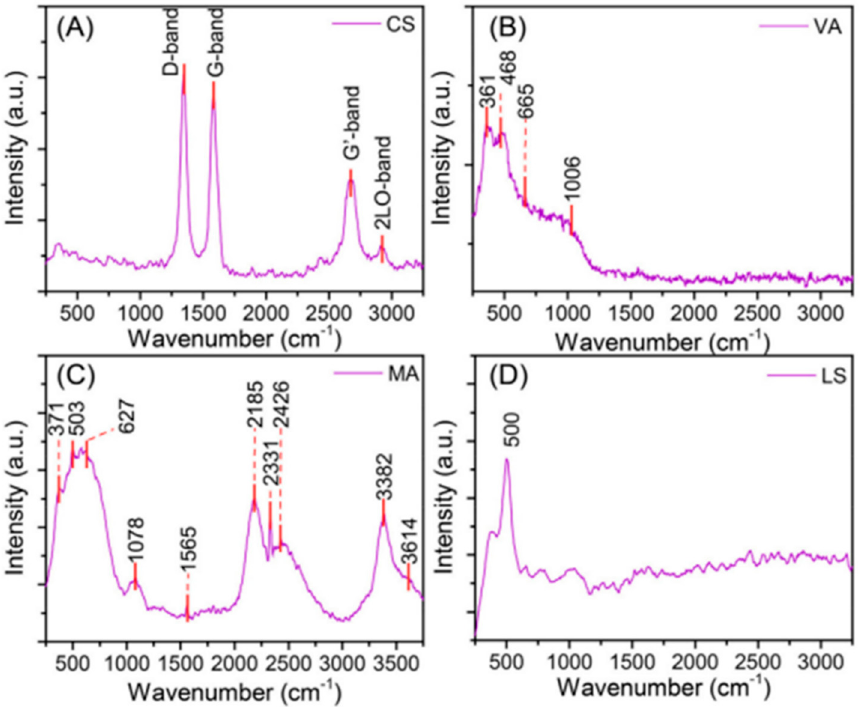
Figure 8. Raman spectra of a single, trapped ( A ) carbon sphere, ( B ) volcanic ash, ( C ) Mars analog, and ( D ) lunar-regolith simulant. (Reproduced with permission from [55]. Copyright 2020, Elsevier).